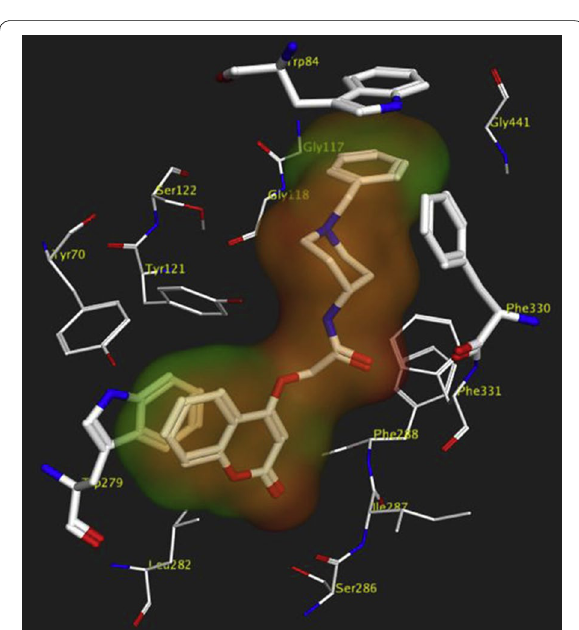
Fig. 7 Proposed binding mode of compound C3 within the active site of TcAChE [27]